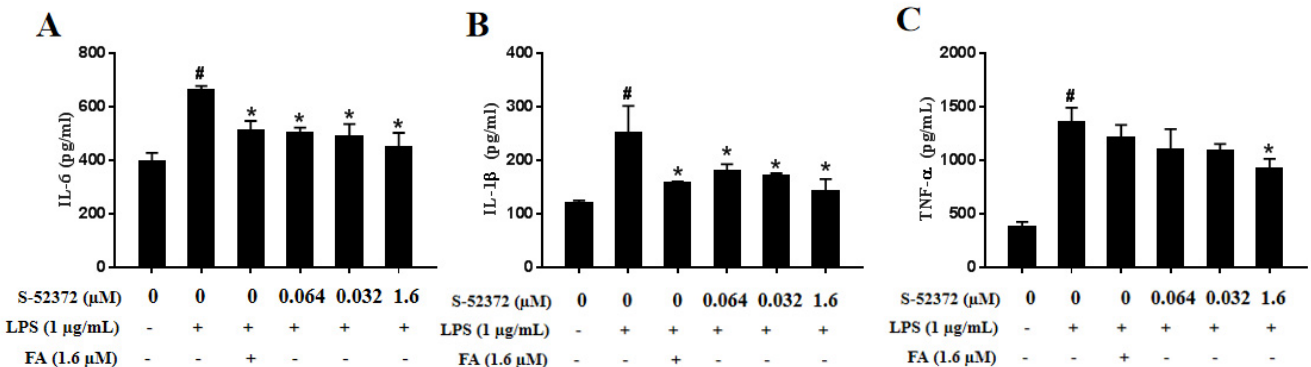
Figure 7. Effects of FA and S-52372 on TNF- α , IL-1 β , and IL-6 induced by LPS. In addition to an untreated control sample, RAW264.7 cells were pretreated with 1.6 μ mol/L of FA as a positive control to compare to RAW264.7 cells pretreated with S-52372 at 1.6, 0.32, and 0.064 μ M for 1.5 h, and then treated all groups with 1 μ g/mL of LPS, except the control group, at 37 °C for 24 h. The levels of ( A ) TNF- α , ( B ) IL-1 β , and ( C ) IL-6 in the culture supernatants of RAW264.7 macrophages were then detected by ELISA. Each bar represents the mean ± standard deviation (SD) calculated from three independent experiments. * p < 0.05 compared to only LPS − treated group; # p < 0.05 compared to the control group.